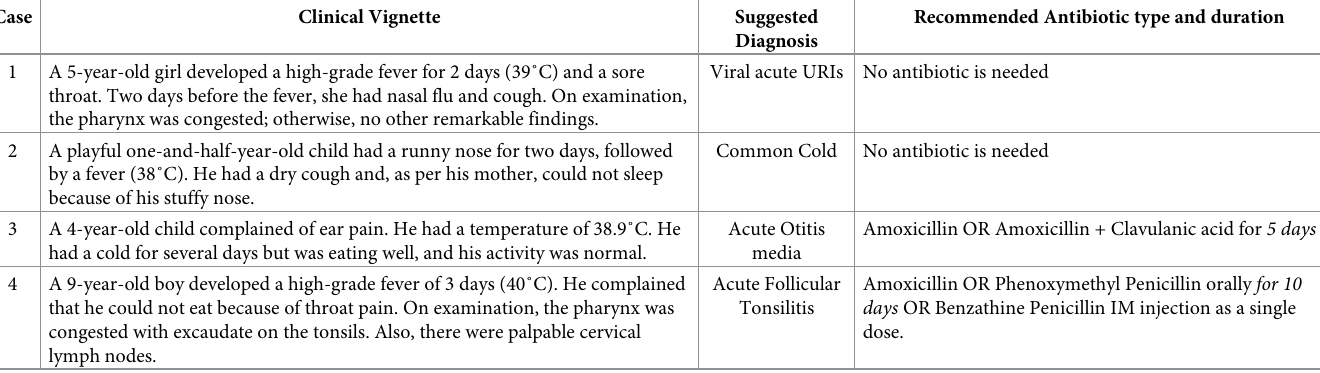
Table 1. Recommended antibiotics for clinical